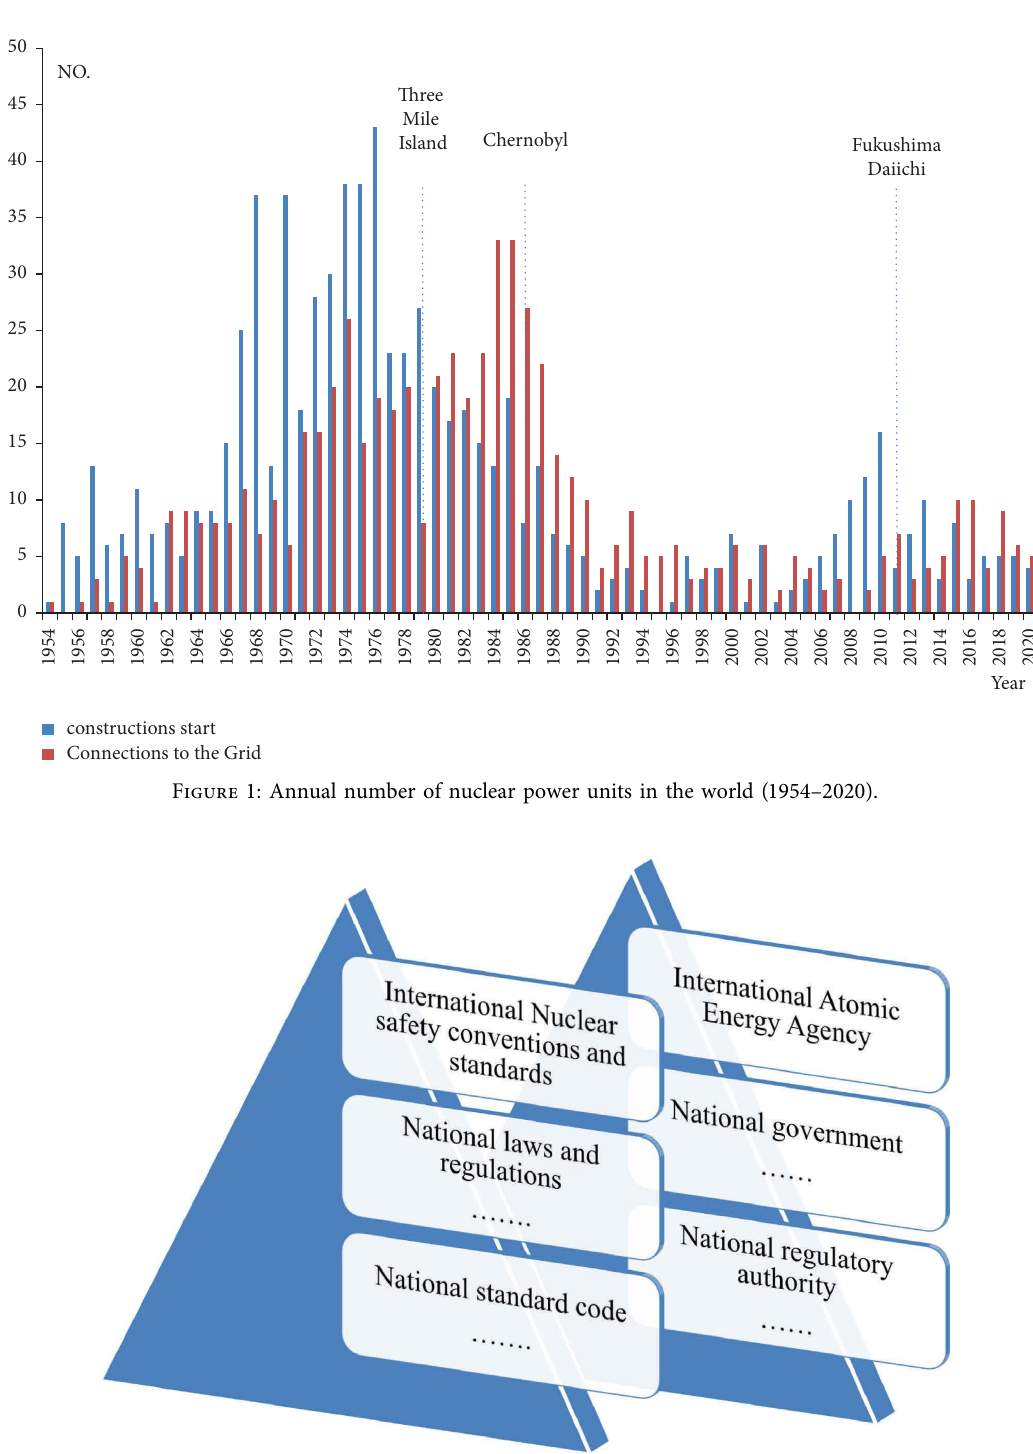
Figure 2: International nuclear safety regulatory